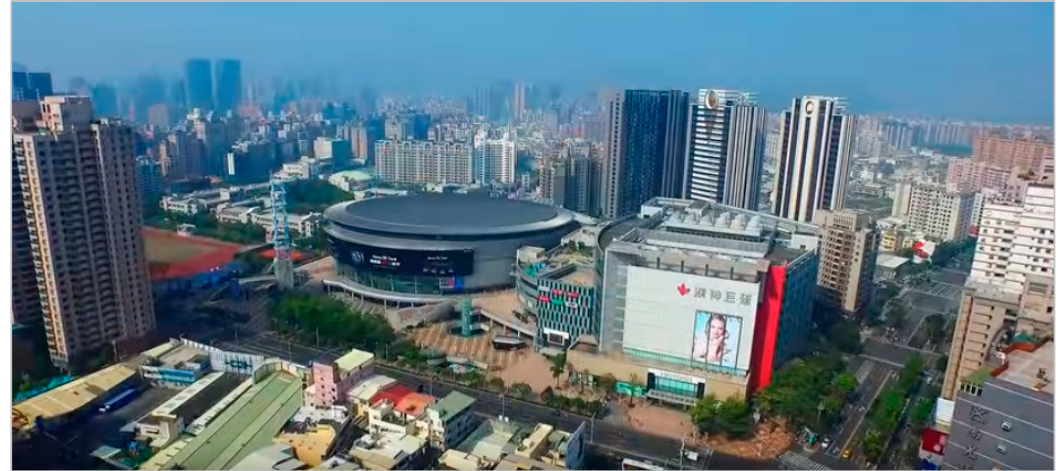
Figure 5. Skyline View of Kaohsiung Dome. (Open Source: Skyline Vision Studio 2015 [21]).